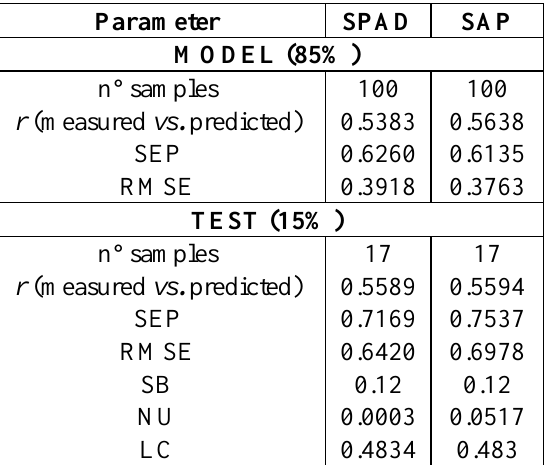
Table 2. Results of linear regression prediction of N concentration in tomato leaves from SPAD (chlorophyll meter readings) and SAP (measurements of N-NO petiole) analysis. Efficiency parameters reported: correlation coefficient ( r ), Standard Error of Prediction (SEP), Root Mean Square Error (RMSE), Squared bias (SB), nonunity (NU) and lack of correlation (LC).